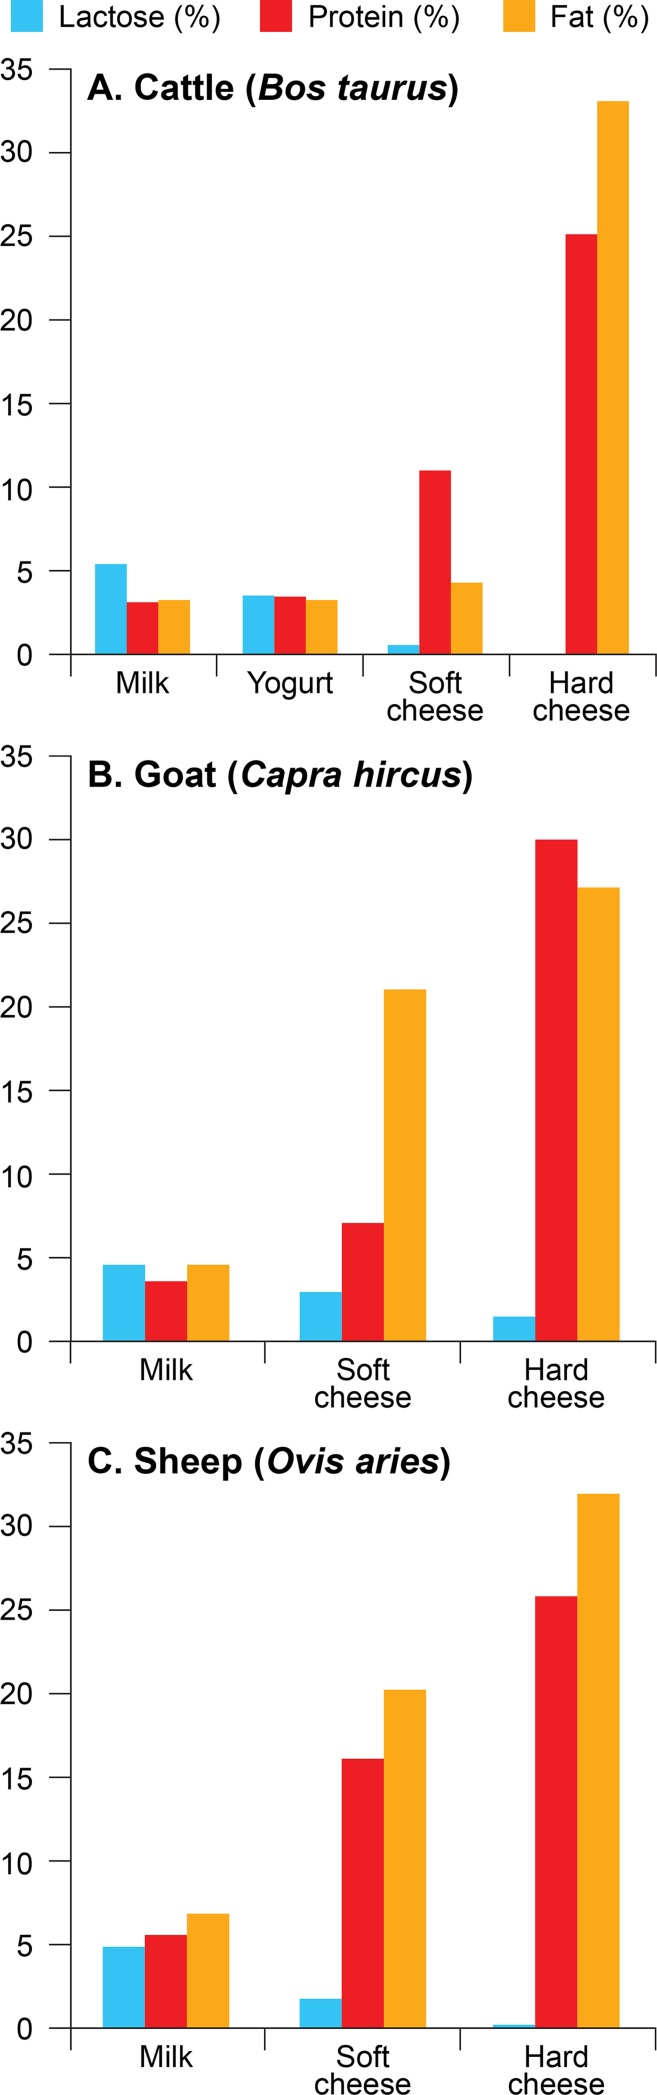
Differences in % lactose, protein, and fat.A. cattle (Bos taurus); B. goat (Capra hircus); and C. sheep (Ovis aries) dairy products [59,64]; see S3 Table for details.